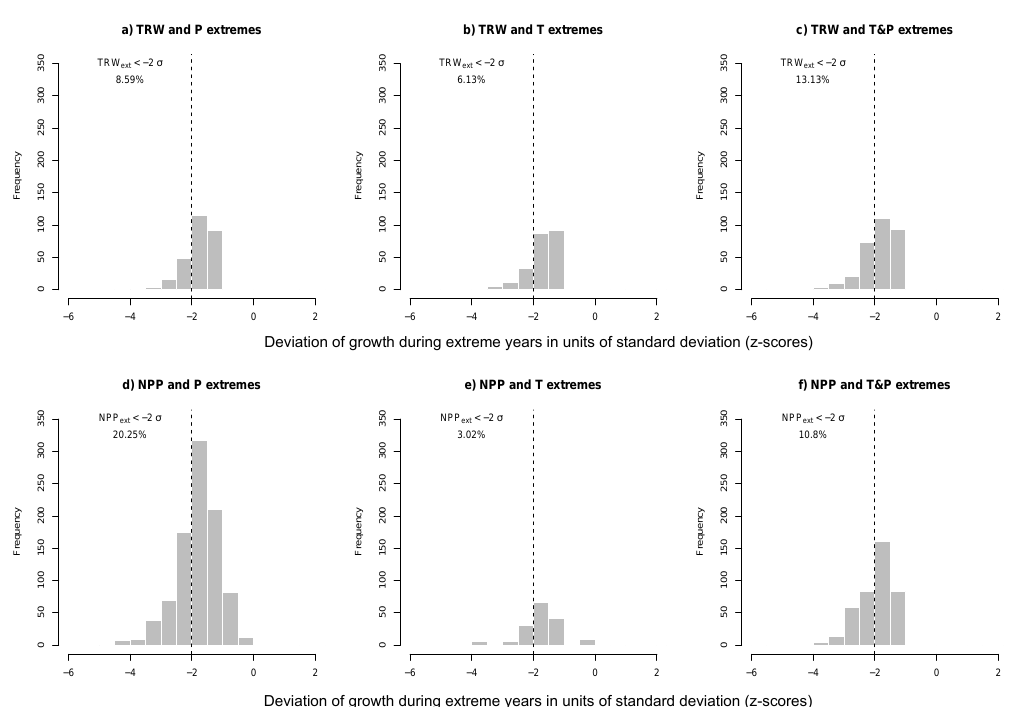
Figure 2. Histograms of deviations of growth responses of TRW (a, b, c) and NPP (d, e, f) during extreme years in units of standard deviations ( z -scores). The vertical dashed grey line marks two negative standard deviations. The numbers denote the proportion of coinciding events below two standard deviations (see also Table S1 in the Supplement).